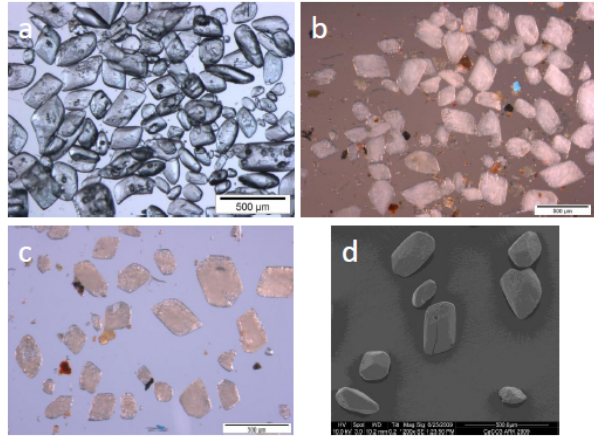
Fig. 2. Light microscopy image (a) of Ikaite crystals from Antarctic sea ice (Dieckmann et al., 2008). Light microscopy image – (b) and (c) – and scanning electron micrograph (d) of ikaite crystals from Kongsfjorden sea ice after transformation into amorphous calcium carbonate.